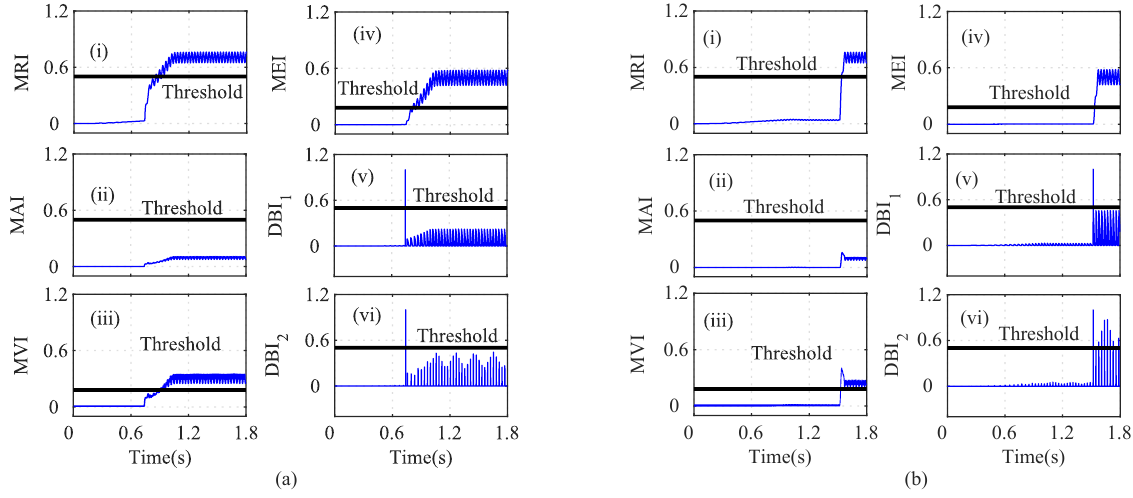
Figure 4. Analysis of residuals for ( a ) I α and ( b ) I β using index-based methods ((i) MRI, (ii) MAI, (iii) MVI, (iv) MEI, (v) DBI 1 and (vi) DBI 2 ) for the I α and I β faults at t = 0.739 s and t = 1.52 .